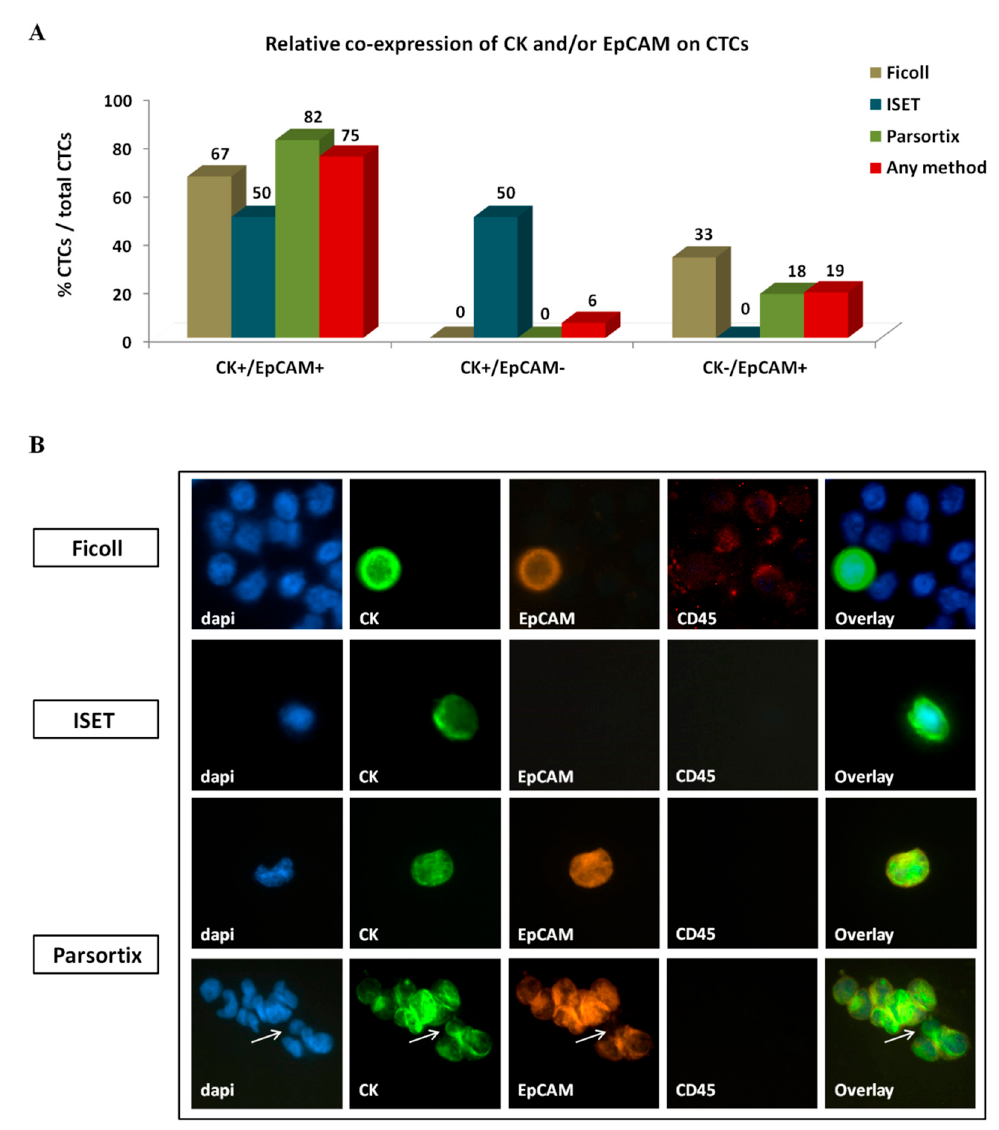
Figure 4. Co ‐ expression of epithelial markers CK and EpCAM on circulating tumor cells Figure 4. Co-expression of epithelial markers CK and EpCAM on circulating tumor cells (CTCs) of (CTCs) of patients with NSCLC: ( A ) Frequency of distinct co ‐ expression phenotypes among patients with NSCLC: ( A ) Frequency of distinct co-expression phenotypes among CTCs identified CTCs identified using different enrichment approaches. Any method depicts the percentage using di ff erent enrichment approaches. Any method depicts the percentage of a specific phenotype of a specific phenotype among the total number of CTCs detected by all methods. ( B ) among the total number of CTCs detected by all methods. ( B ) Representative images of CTCs enriched Representative images of CTCs enriched by different methods: All depicted cells co ‐ express by di ff erent methods: All depicted cells co-express CK +/ EpCAM + , except the ISET-enriched cell CK+/EpCAM+, except the ISET ‐ enriched cell which is of the CK+/EpCAM ‐ phenotype. A which is of the CK +/ EpCAM- phenotype. A CTC cluster identified by Parsortix is also depicted, CTC cluster identified by Parsortix is also depicted, expressing CK+/EpCAM+ in all except expressing CK +/ EpCAM + in all except one cell, which is of the CK +/ EpCAM − phenotype (arrow). one cell, which is of the CK+/EpCAM − phenotype (arrow). Ariol microscopy system, Genetix, Ariol microscopy system, Genetix, New Milton, UK) (400 × New Milton, UK) (400×).